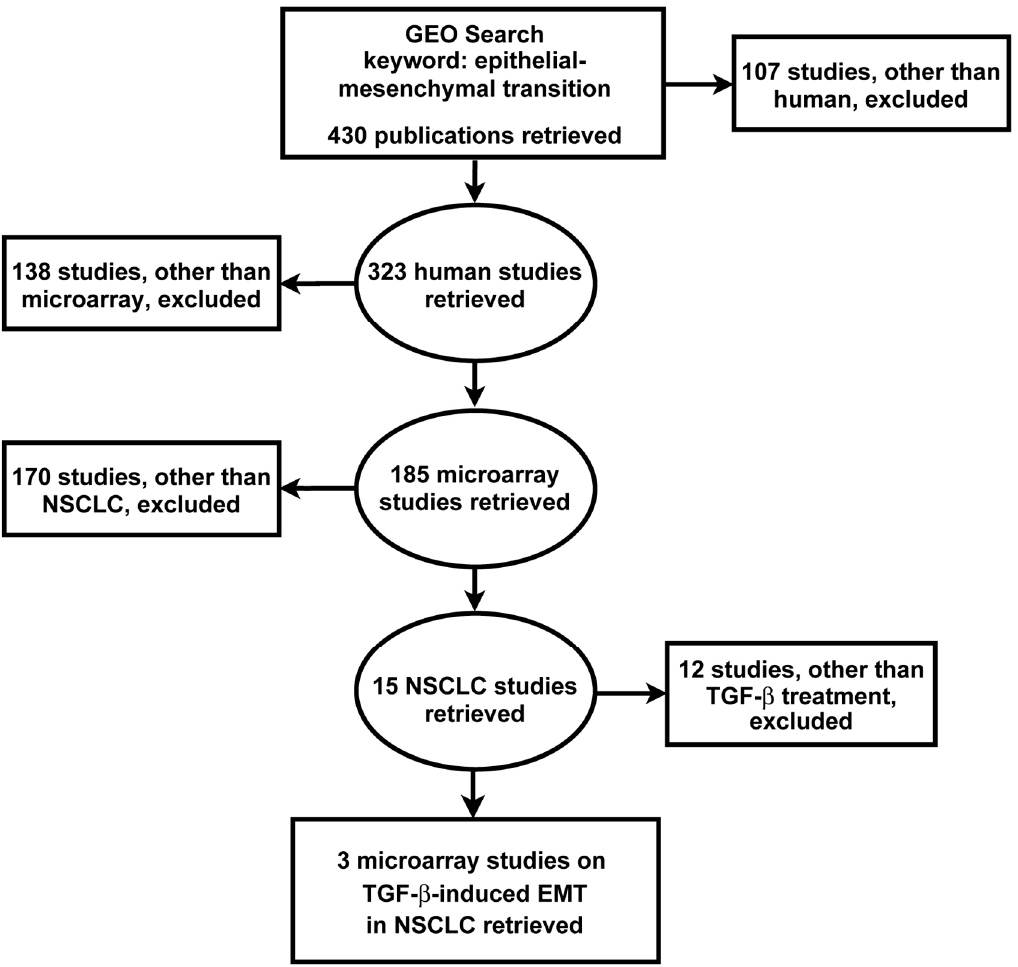
Figure 1. Search strategy for the identification, screening and selection of eligible gene expression studies. Searching the GEO yielded 430 studies which were screened by applying the indicated exclusion criteria. Three microarray datasets met the search criteria for subsequent integrated bioinformatics analysis of TGF- β -induced EMT in NSCLC cells.